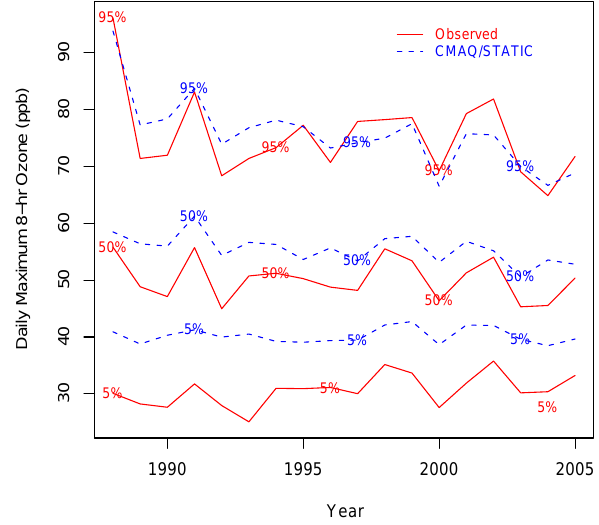
Fig. 5. Time series of the 5th, 50th, and 95th summertime percentiles estimated from observed and CMAQ/STATIC simu- lated May–September 8-h daily maximum ozone concentrations for 1988–2005. The time series represent spatial averages over the lo- cation of the 90 ozone monitors in the modeling domain.